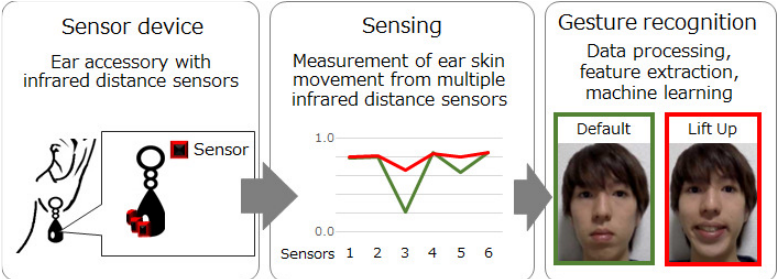
Figure 1. Flowchart of the proposed method. Reprinted/adapted with permission from Ref. [11] 2021, ACM.